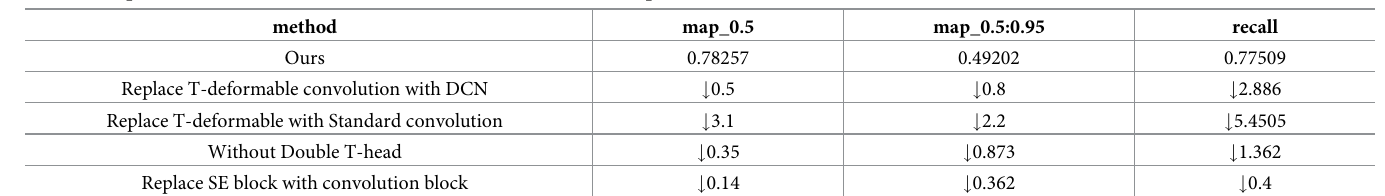
Table 3. Map metrics and recall metrics for each network in the ablation